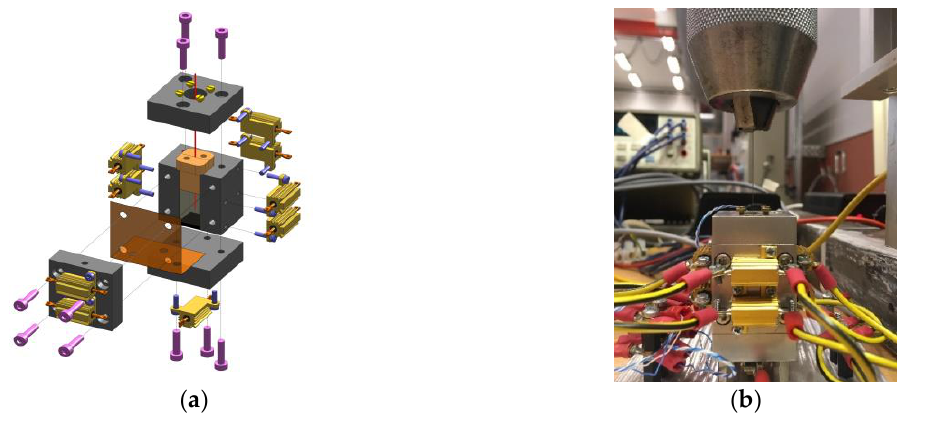
Figure 2. ( a ) Geometry of the injection cell; ( b ) the finished setup.